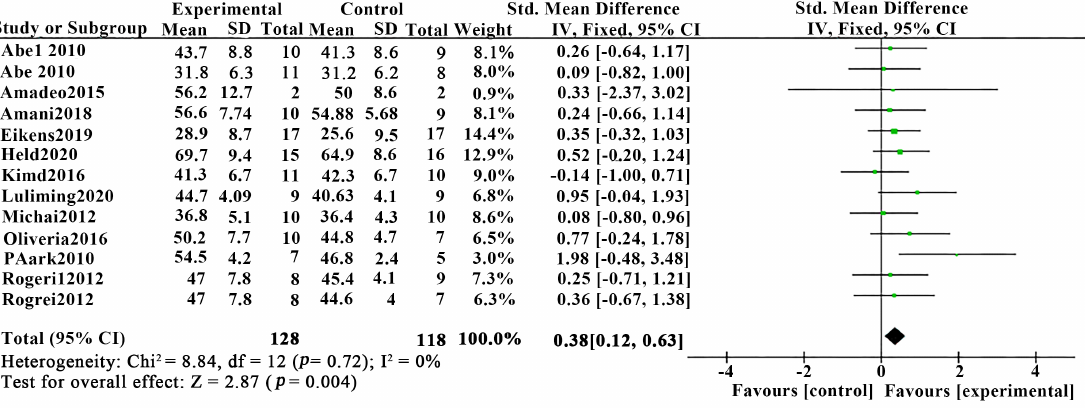
Fig. 5. Forest plot of aerobic capacity(mL/min/kg) improvement by blood flow restriction